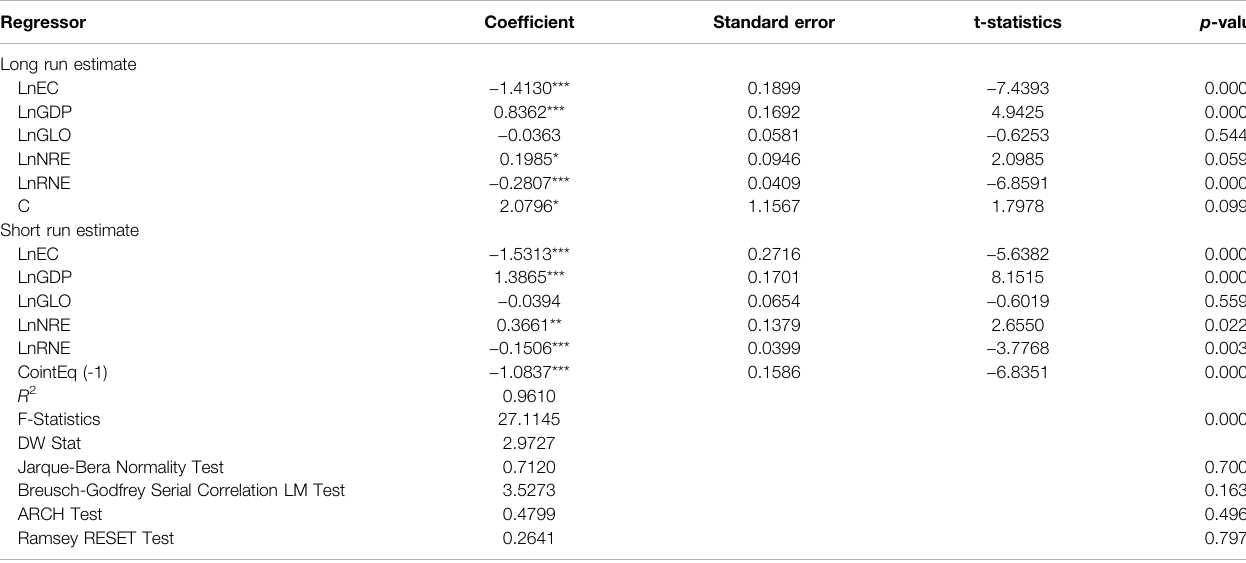
TABLE 7 | Results of long-run and short-run estimation